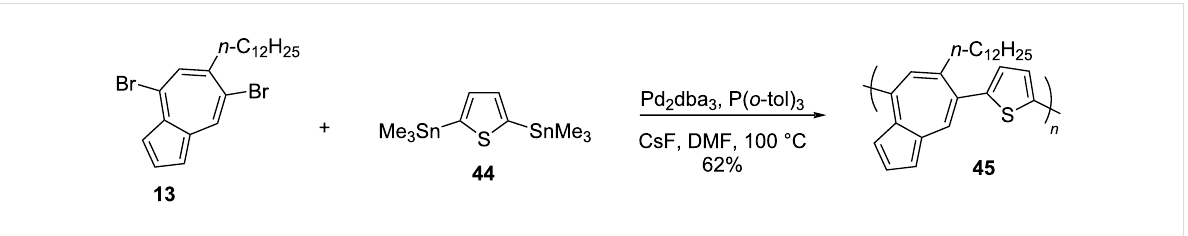
Scheme 9: Synthesis of polymer ruthenium complexes 40 – 43 .